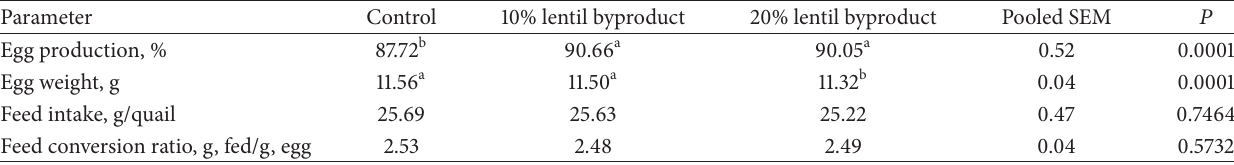
Table 3: The effect of the dietary inclusion of lentil byproduct on egg production, FCR and feed intake, and egg weight of quails. Parameter